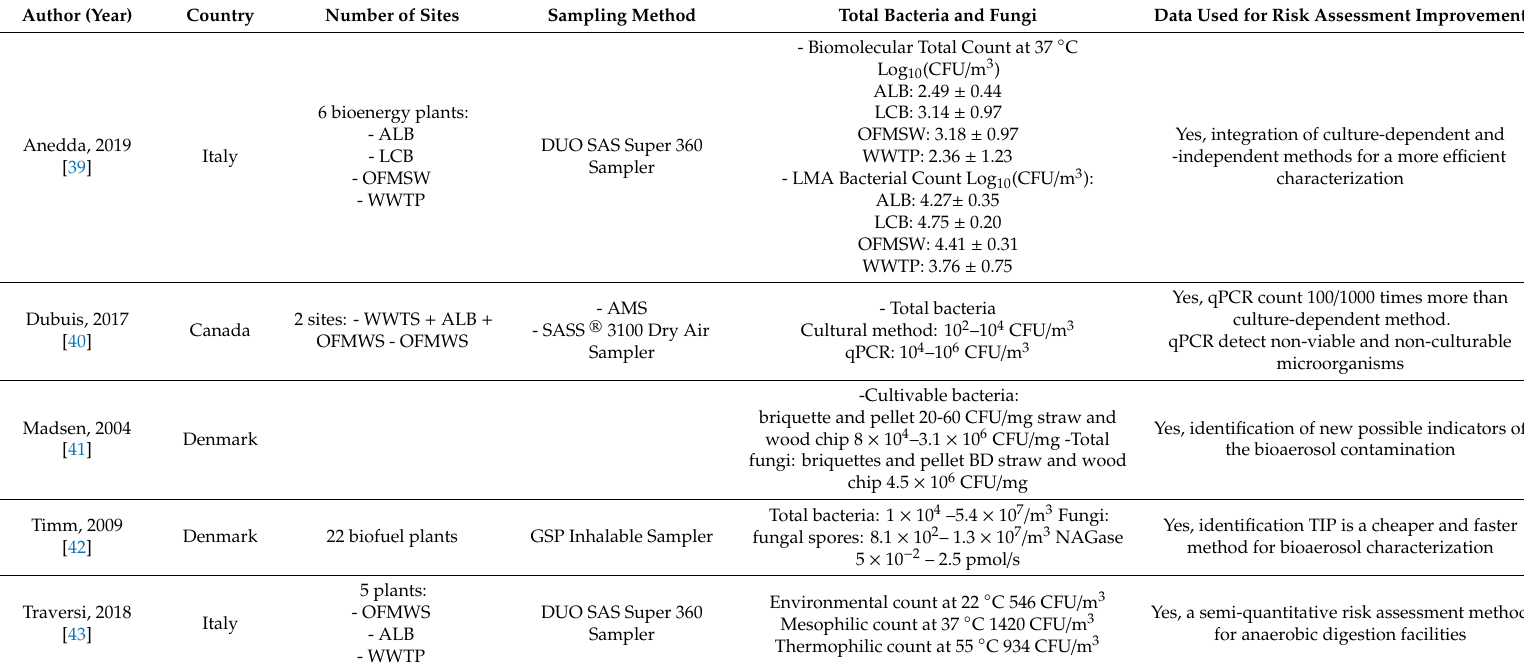
Table 2. Bioaerosol studies in biomethanization facilities that presented total bacteria and / or fungi